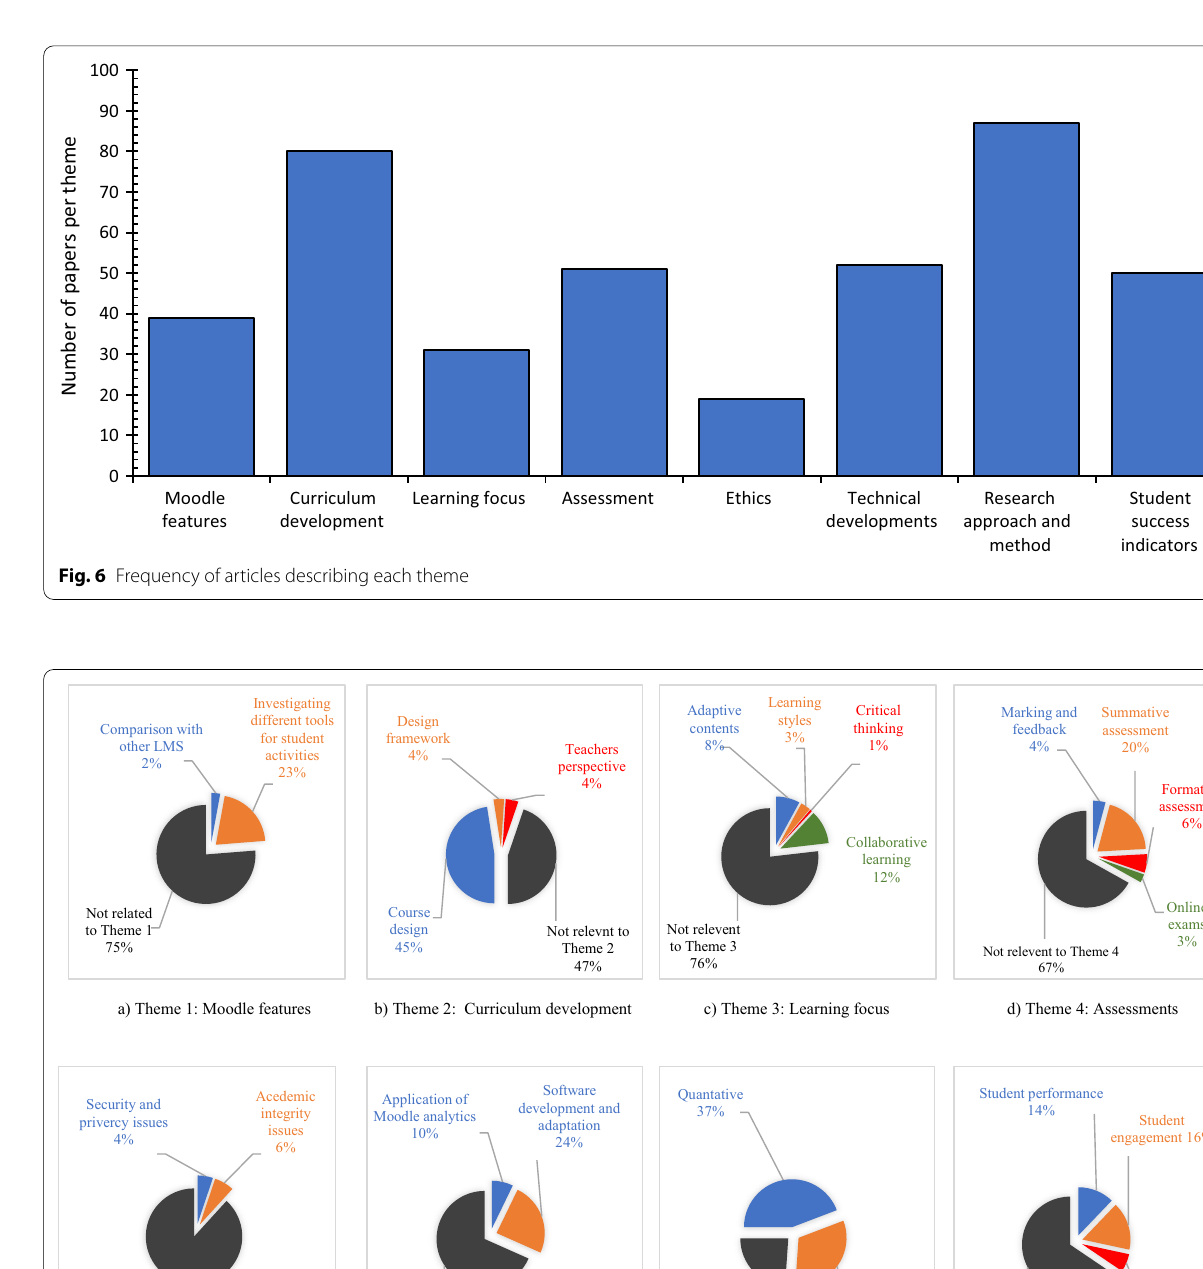
a) Theme 1: Moodle features